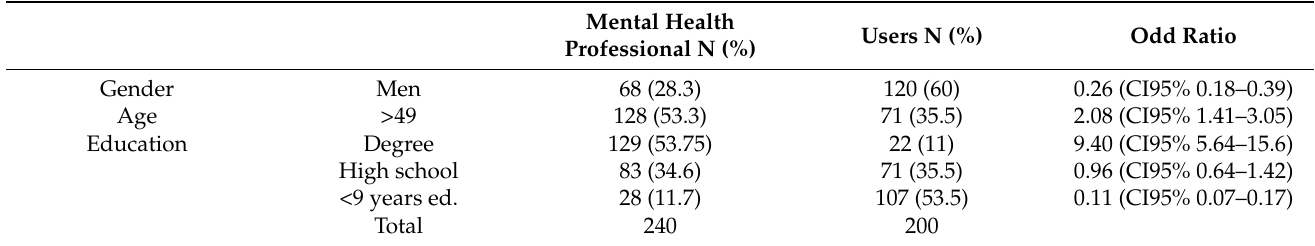
Table 1. Socio-demographic characteristics of the study